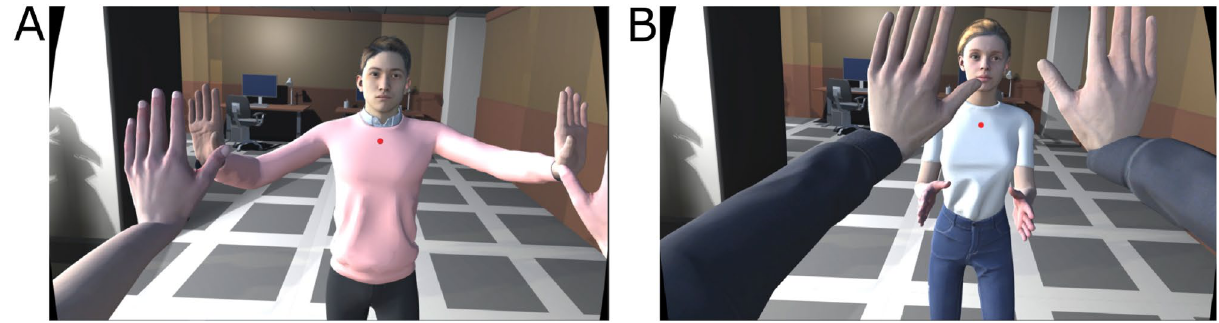
Figure 1. The virtual environment as seen from the perspective of two participants. In ( A ) we see an instant of time where behaviour is synchronous. In ( B ) we see the same virtual scene from the perspective of the other participant, when the behaviour has not synchronised. Note that the gender of the virtual character matched the gender reported at the beginning of the experiment by the other participant doing the task